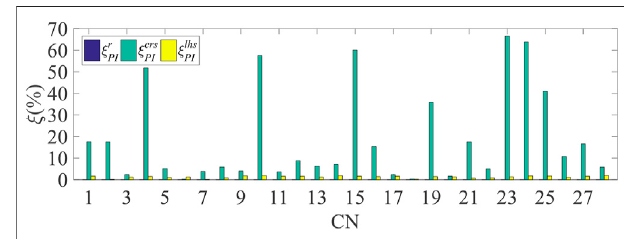
FIGURE 4 | Security index error of different sampling